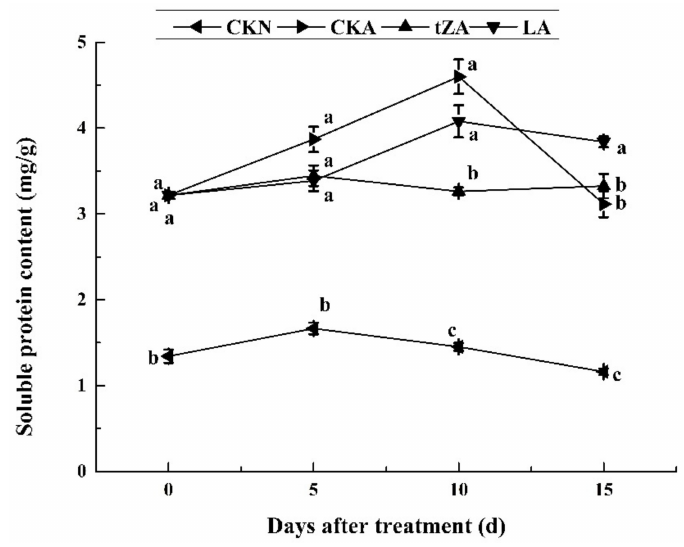
Figure 4. The changes in the soluble protein content in CKN, CKA, tZA and LA groups after treatment. Different lower-case letters among different treatment groups indicate significant differences based on one-way analysis of variance in SPSS 21.0 followed by the Duncan’s test ( p < 0.05).